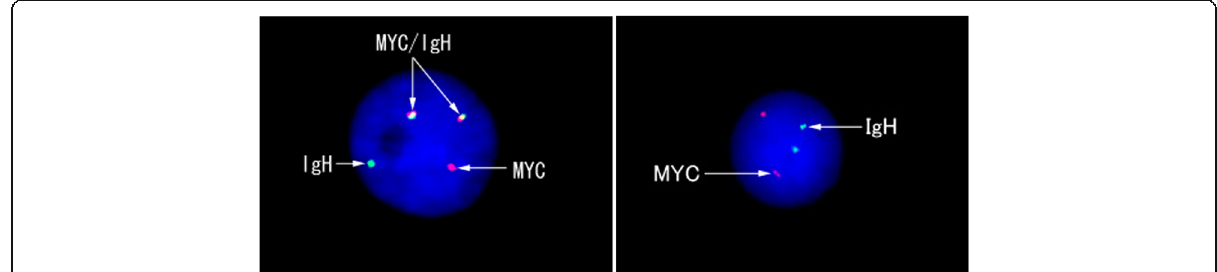
Fig. 5 MYC/IgH fluorescence in situ hybridization of thyroid Burkitt ’ s lymphoma. Left: The MYC/IgH translocation is demonstrated with 1 separate green signal, 1 separate red signal, and 2 fused green/red signals on the tumor cell. Right: Normal human lymphocyte as a control indicated by 2 red and 2 green